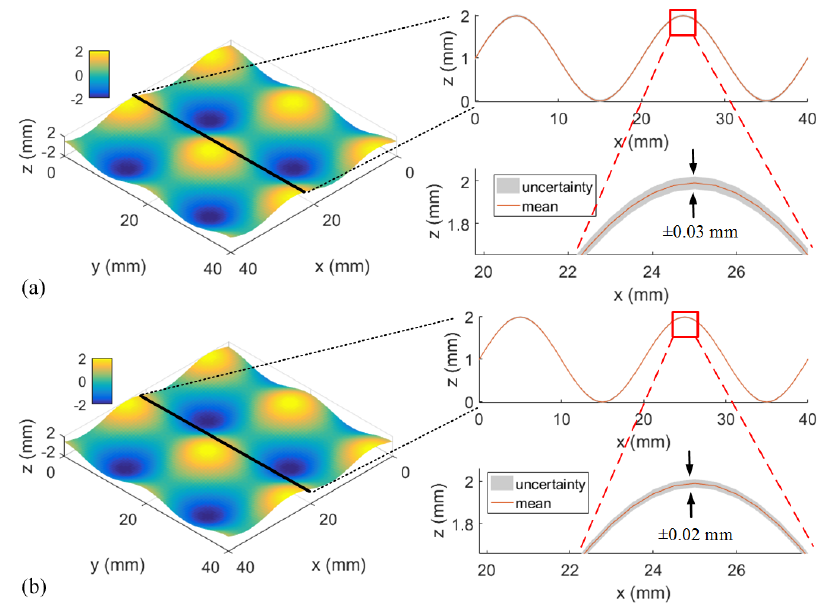
Figure 7. Gaussian process modelling results of the two simulated measured datasets: ( a ) with 30 μ m measurement noise; and ( b ) with 20 μ m measurement noise.